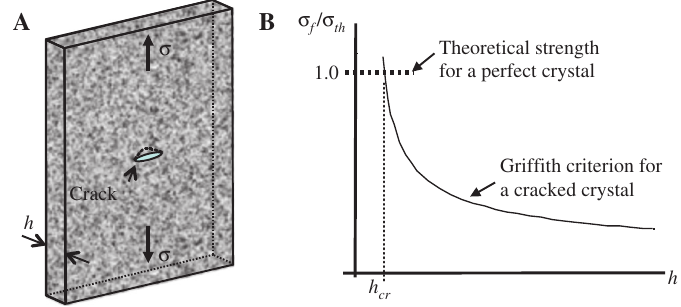
vs. thickness plot, based on the Griffith criterion and schematic of h for the Hall-Petch relation, h , indicating mean grain size in the latter case. The critical mean grain size based on the Hall-Petch relation is unrelated to h . For non-crystalline materials, Hall-Petch effects do not cr